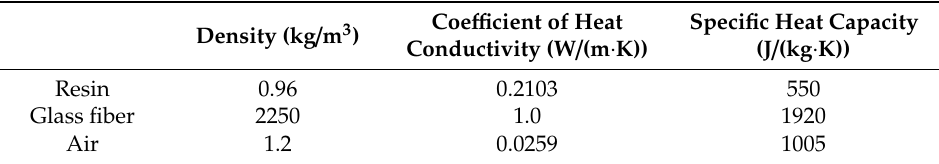
Table 2. Physical properties of glass fibers and